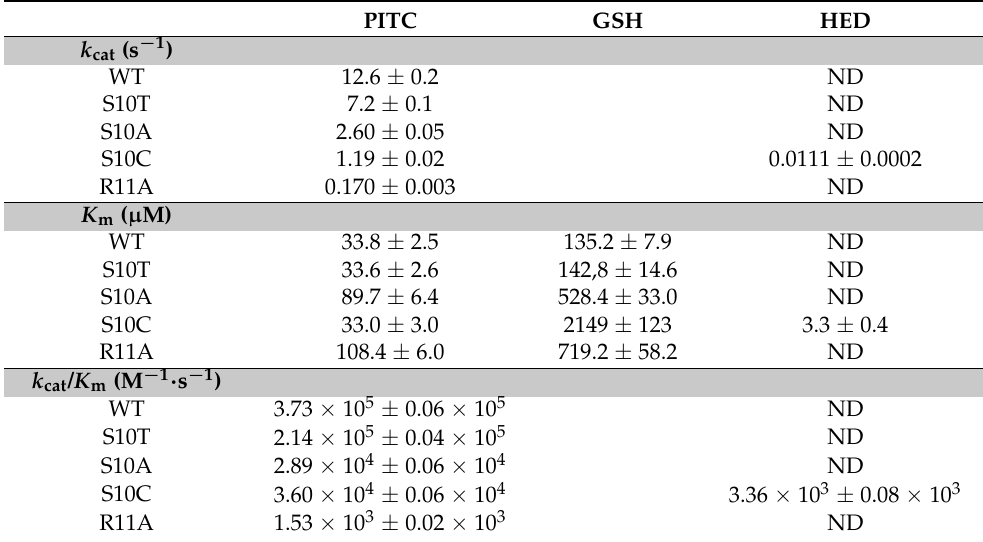
Table 2. Kinetic parameters of SynGSTC1 toward model